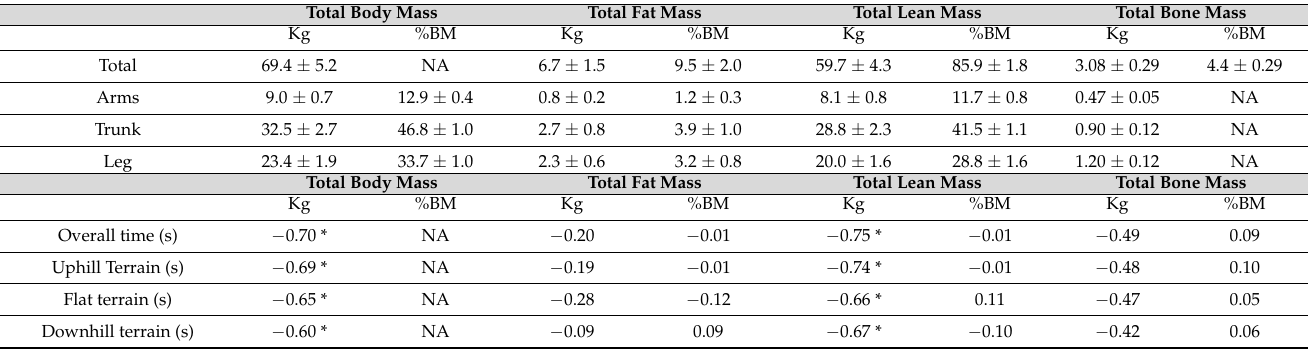
Table 4. Body composition presented in absolute values (kg) and relative to total body mass (%BM) for arms, trunk, and legs, as well as correlations with overall time during a 10 km skating time-trial in fourteen national-level male cross-country skiers.